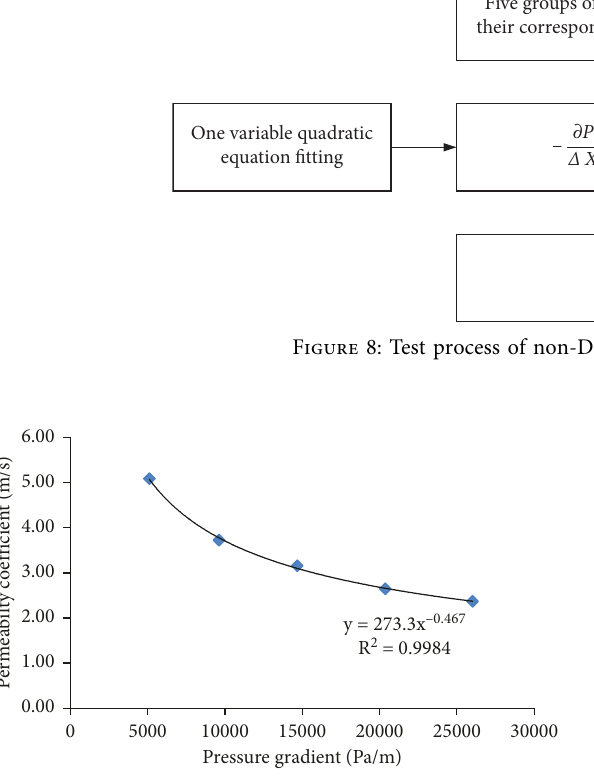
Figure 9: Permeability coefficient vs. pressure gradient.